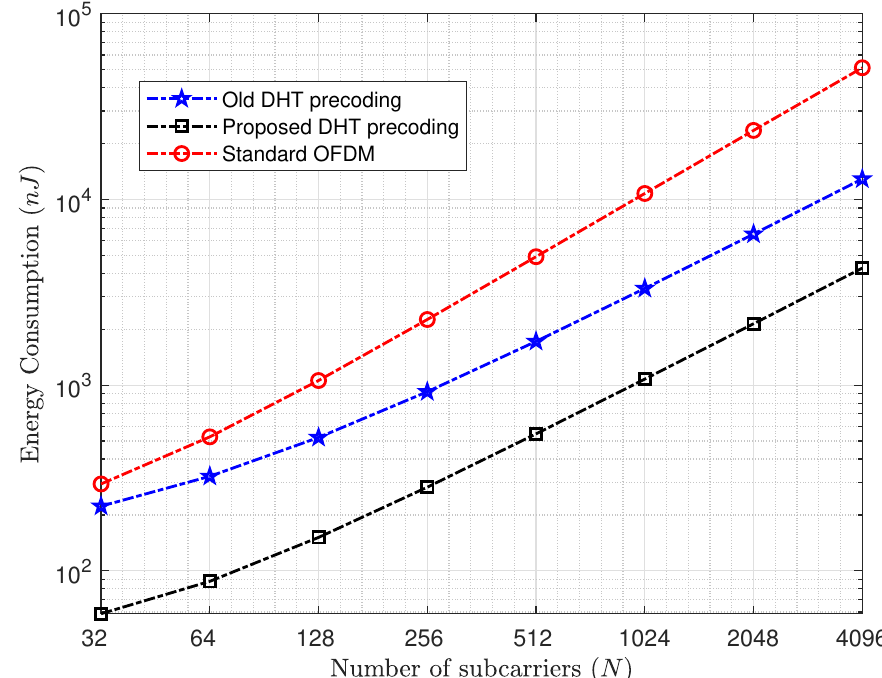
Figure 6. Comparison of energy consumption per N -point FFT/IFFT of OFDM, DHT-precoded OFDM and